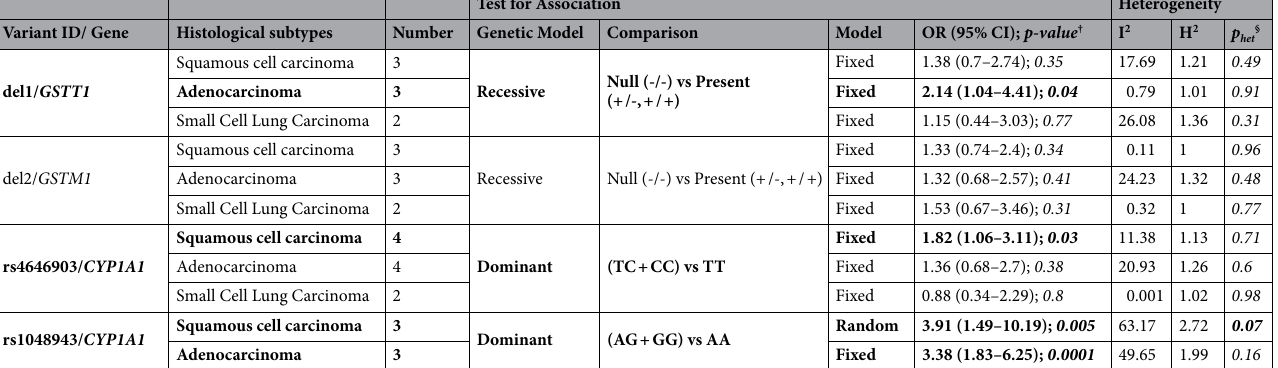
Table 3. Results of the histological subtype-stratified meta-analysis of reported lung cancer variants in the Indian subcontinent. † p-value < 0.05*, 0.01**, 0.001***, OR, Crude Odds Ratio, 95% CI, 95% Confidence Interval, I 2 and H 2 are measures of heterogeneity. § p Het < 0.1 (Cochran’s Q test). Significant associations are depicted in